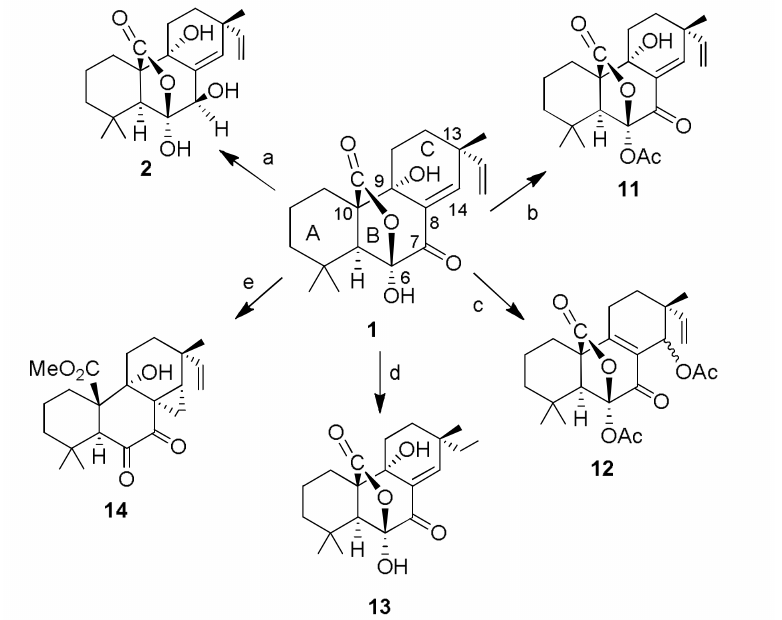
Figure 1. The structures of sphaeropsidins A–F ( 1 – 6 ) and sphaeropsidones ( 7 and 8 ) and their chlorinated analogs ( 9 and 10